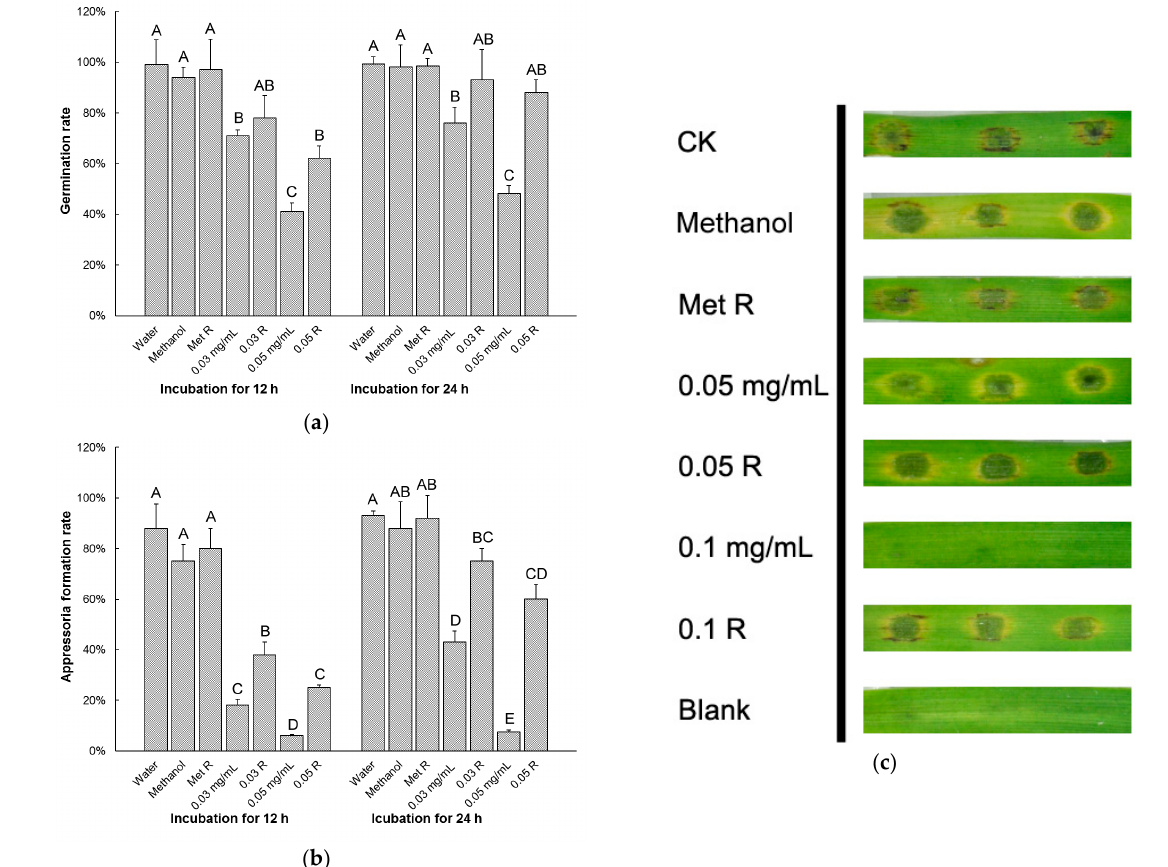
Figure 6. The inhibition of equol to conidial germination, appressorial formation, and pathogenicity is restorable by removing the equol. The conidia suspensions (1 × 10 5 conidia/mL) that were supplemented with 0.03 and 0.05 mg/mL ( S )-equol, and those that were treated with 0.03 and 0.05 mg/mL ( S )-equol for 2 h then washed in sterilized water three times (0.03 R and 0.05 R) were incubated on a plastic coverslip at 28 °C for 24 h to allow for germination and appressorial formation. Conidial germination ( a ) and appressorial formation ( b ) at 12 and 24 h post incubation were examined and statistically compared. The error bars represent the deviation calculated from three replicates. The letters in capital on top of the columns represent the significance of the difference ( p < 0.01) between the treatments in each time point; ( c ) The conidia suspensions (1 × 10 5 conidia/mL) that were supplemented with 0.05 and 0.1 mg/mL ( S )-equol, and those that were treated with 0.05 and 0.1 mg/mL ( S )-equol for 2 h and then washed in sterilized water three times (0.05 R and 0.1 R) were inoculated on 7-day-old barley ZJ-8 leaves and then incubated at 28 °C in darkness for 24 h and a subsequent 12 h light/12 h darkness cycle for 3 days. Conidia suspensions that were untreated (CK), treated with 0.2% methanol, and treated with 0.2% methanol for 2 h then washed with sterilized water (Met R) in the same procedures were used as controls. The plants inoculated with sterilized water were used as a blank control.